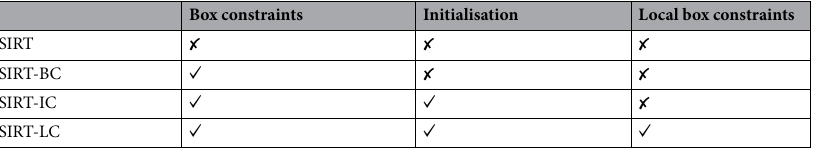
Table 1. An overview of the different approaches used for the four SIRT reconstruction algorithms that were tested. See text or the “Reconstruction” section for a detailed explanation.